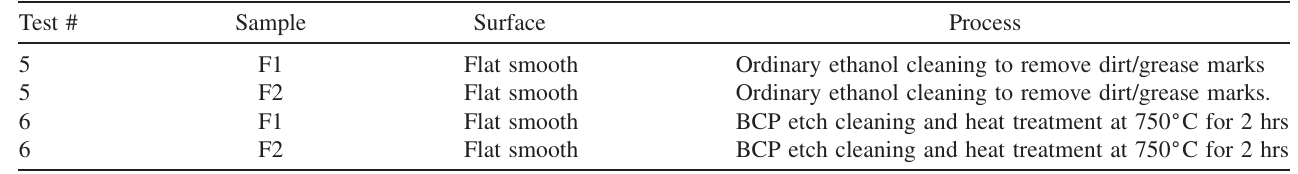
TABLE II. Bulk preparation of two flat plate niobium